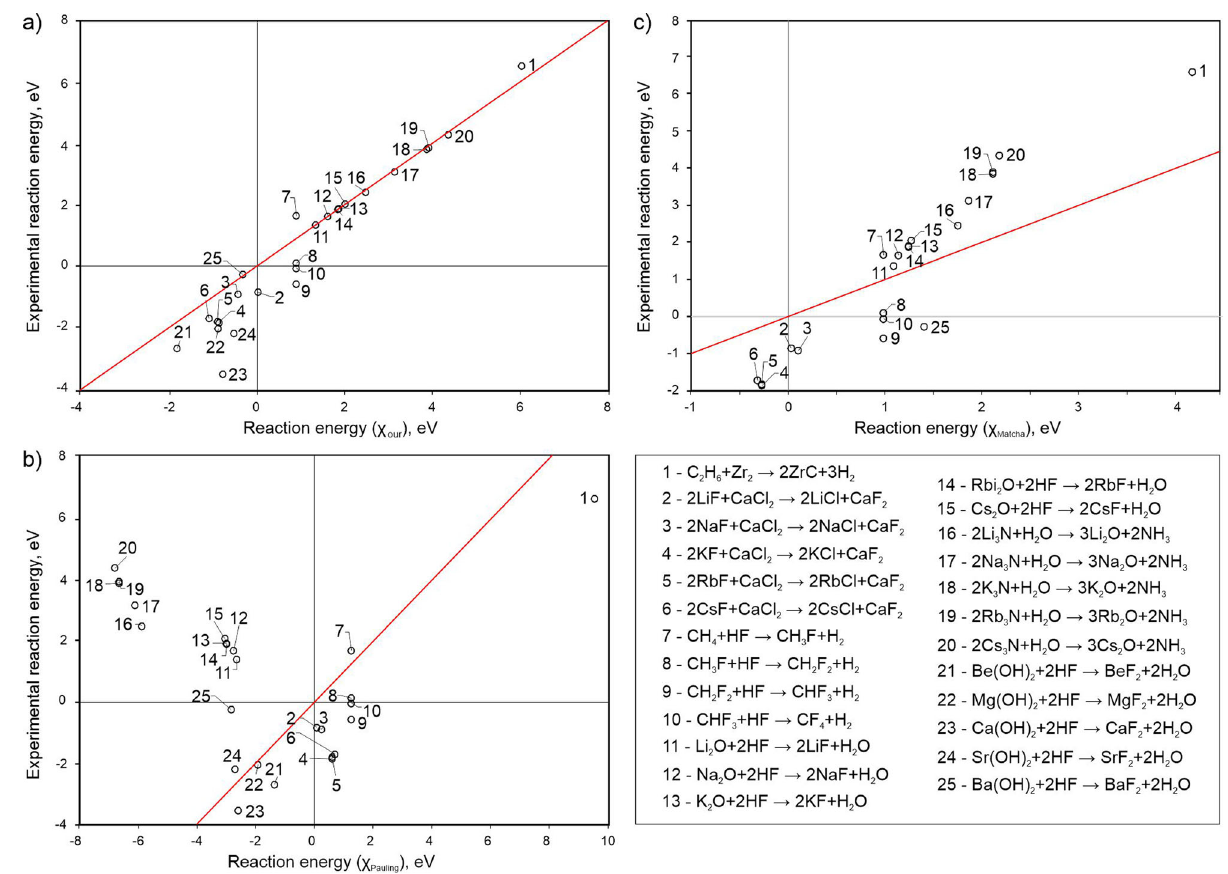
Fig. 5 Comparison between predicted energies of 25 exchange reactions from thermochemical electronegativities ( x -axis) and and experimental energies on y -axis. ( a ) Experimental vs our, ( b ) experimental vs Pauling ’ s ( c ) and experimental vs Pauling ’ s corrected by Matcha 8 . Lines indicate the ideal result (the root-mean-square deviations are equal to 0.9 eV for our approach, 5.1 eV for Pauling ’ s and 1.9 eV for Matcha ’